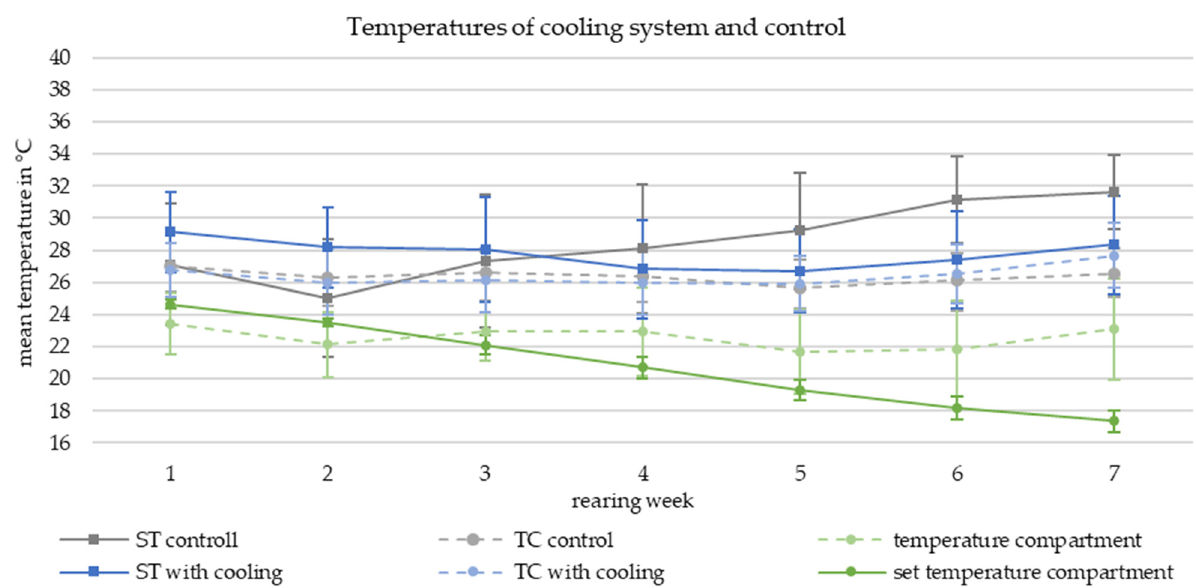
Figure 4. An average profile of all surface temperatures (ST) of the lying areas (12 sensors) and the air temperatures under the covers (TC) (eight sensors) and in the compartments (four sensors), as well as the set air temperature in the compartments over all three cooling periods. The mean temperatures for each rearing week, which were formed from the records taken every minute over the three rearing periods, are shown. The bars drawn at each data point indicate the standard